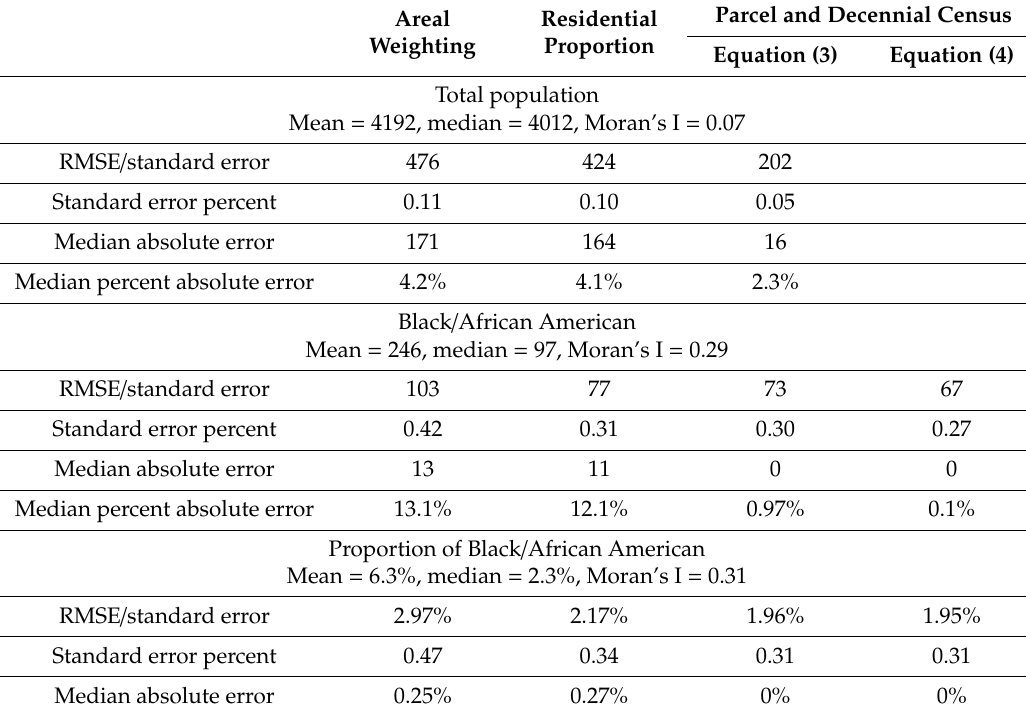
Table 2. Accuracy assessment of the three areal interpolation